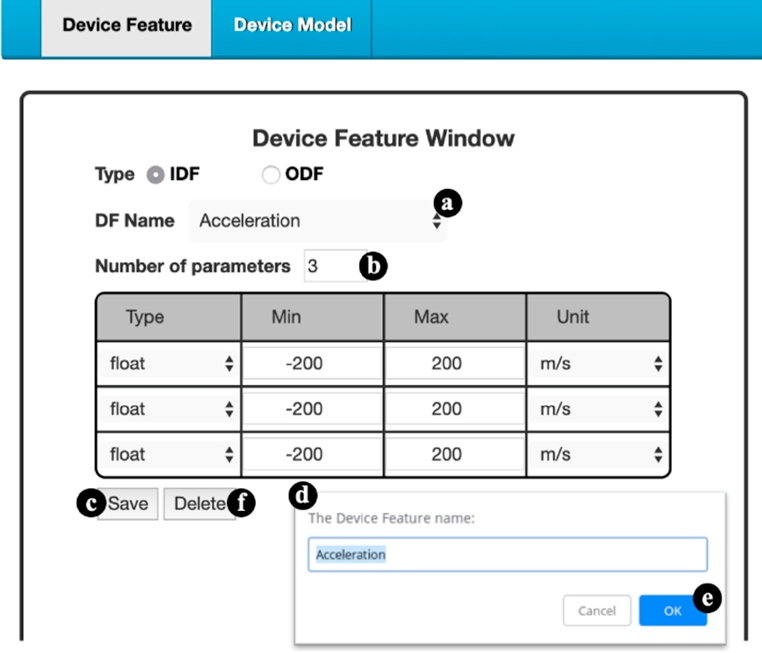
Figure A4. Device feature modification.